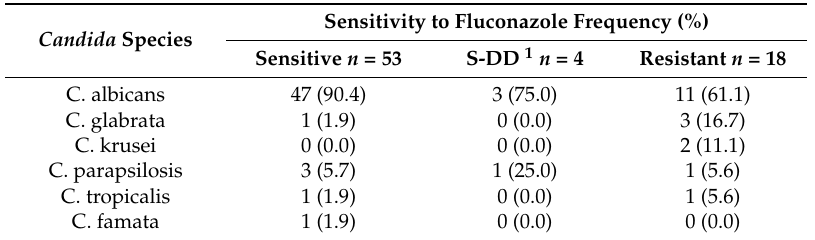
Table 1. In vitro fluconazole sensitivity profile of Candida isolates in